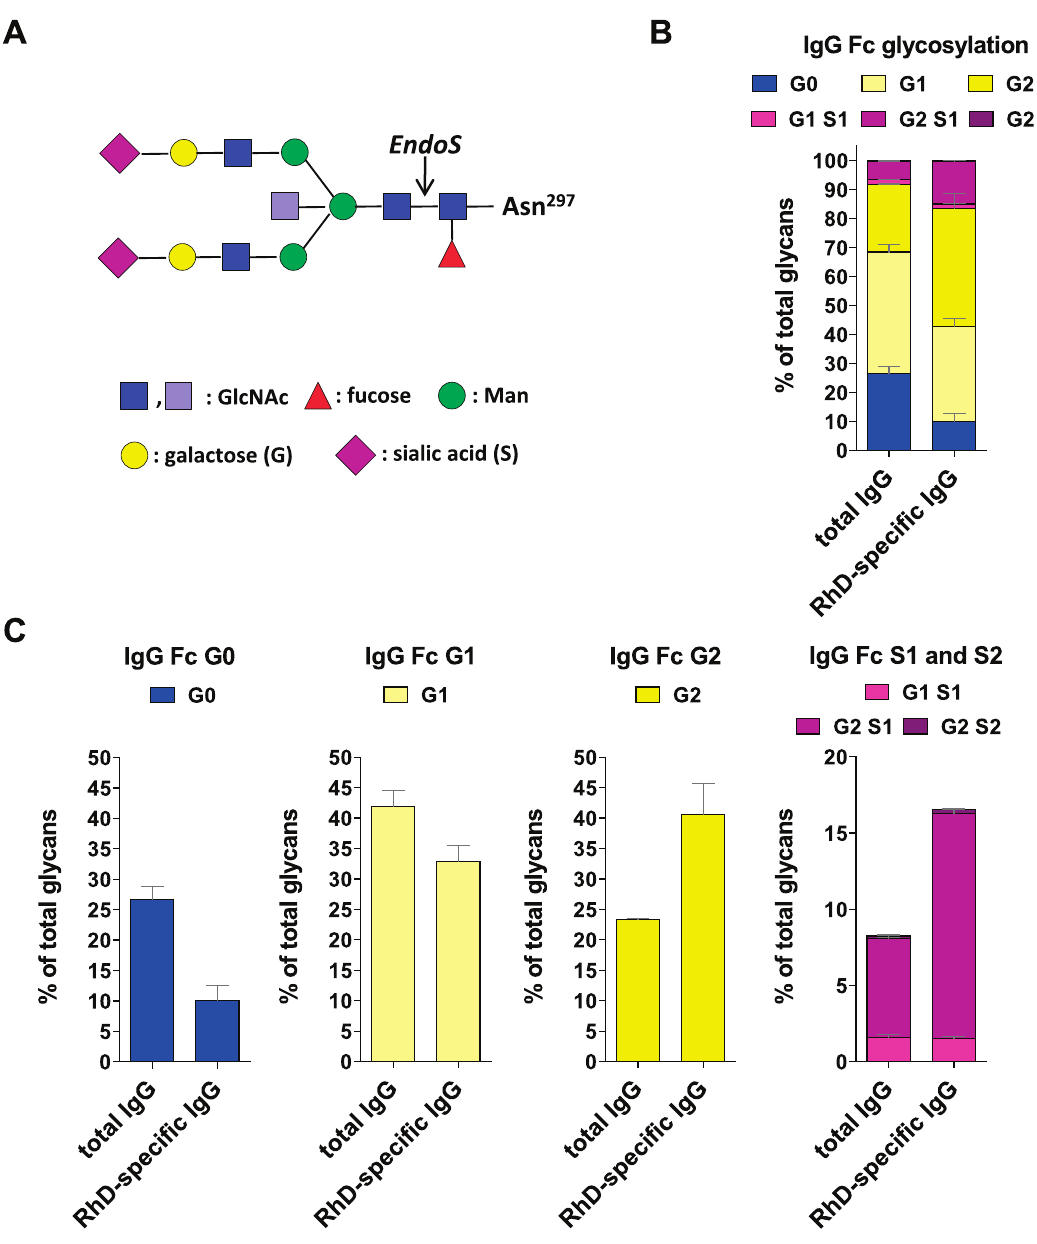
Figure 1. Polyclonal RhD-specific IgG Abs in Rhophylac® are sialylated. ( A ) The biantennary IgG Fc glycan core structure, which is coupled to Asn 297, consists of two N-acetyl-glucosamines (GlcNAc; dark blue) and three mannoses (Man), which can be further decorated with fucose; bisecting GlcNAc (light blue) and terminal GlcNAc (dark blue), galactose (G) and sialic acid (S). ( B and C ) The purified total and RhD-specific IgG samples were hydrolyzed with EndoS and analyzed by MALDI-TOF MS. The cleavage site of EndoS is indicated by an arrow in ( A ). ( B ) The bar graph indicate the frequency of all glycan structures with 0, 1 or 2 galactose (G) residues and 0, 1 or 2 sialic acid (S) residues. The mean values with the standard error of the mean (SEM) from independent experiments are shown. ( C ) The bar graphs separately indicate the frequency of G0, G1, G2 and S1 and S2 glycan structures from the bar graph in ( B